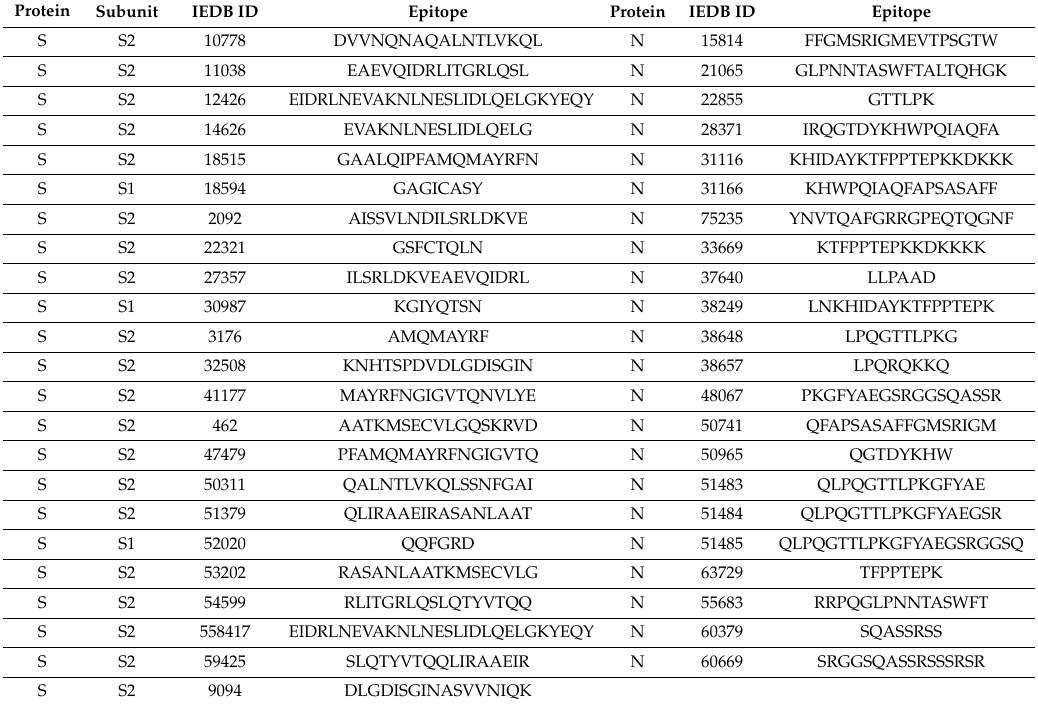
Table 4. SARS-CoV-derived linear B cell epitopes from S (23; 20 of which are located in subunit S2) and N (22) proteins that are identical in SARS-CoV-2 (45 epitopes in total). Protein Subunit IEDB ID Epitope Protein IEDB ID